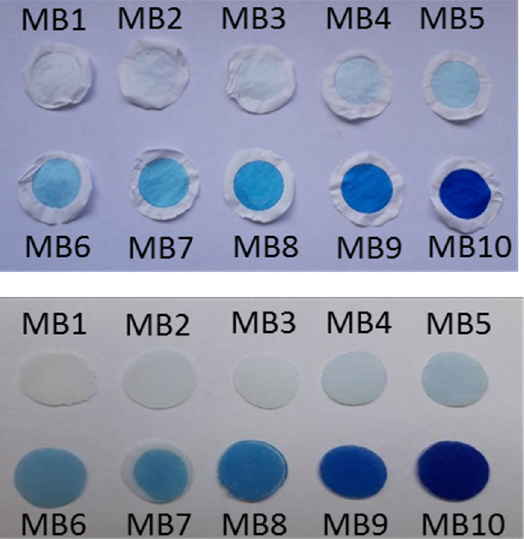
Figure 5. Photographs of the films of organoclays functionalized with methylene blue deposited on filtration membranes ( top ) and membranes of corresponding composites with the polymer ( bot- tom ).